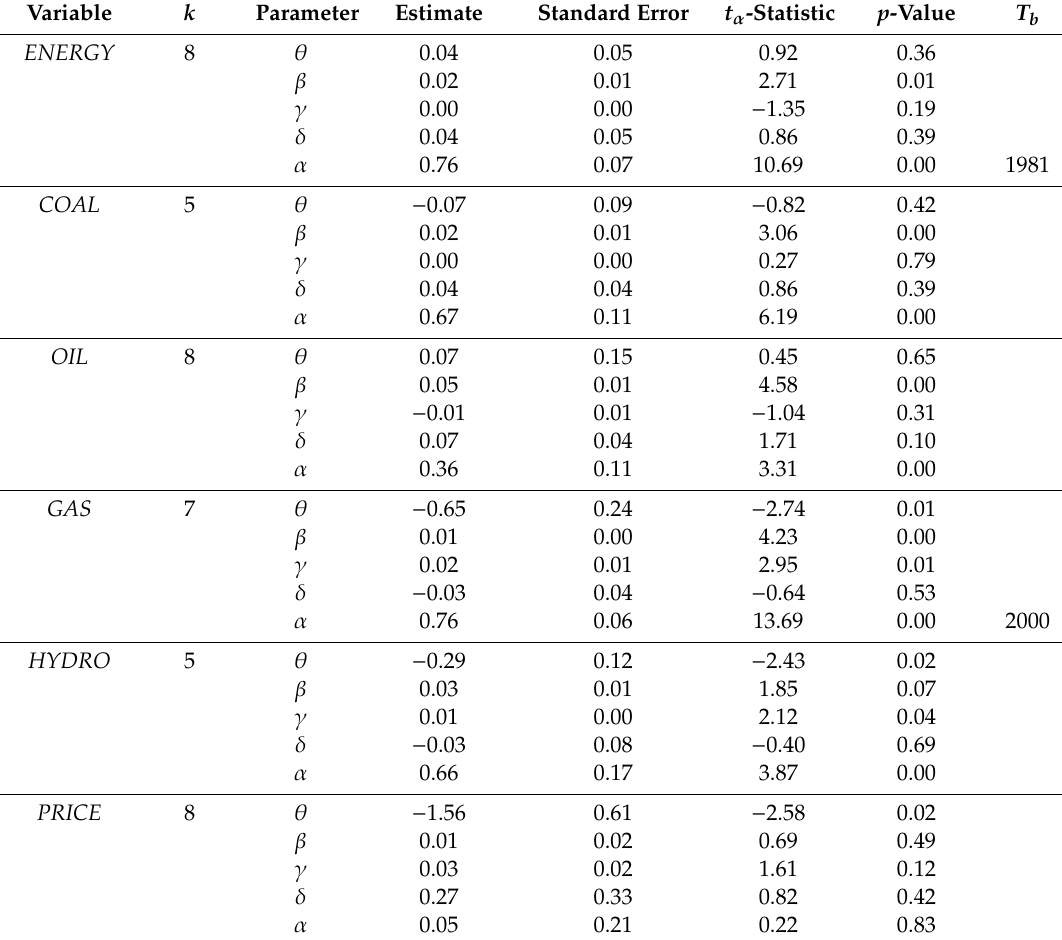
Table 2. Break date tests using the Perron innovational outlier (IO) model